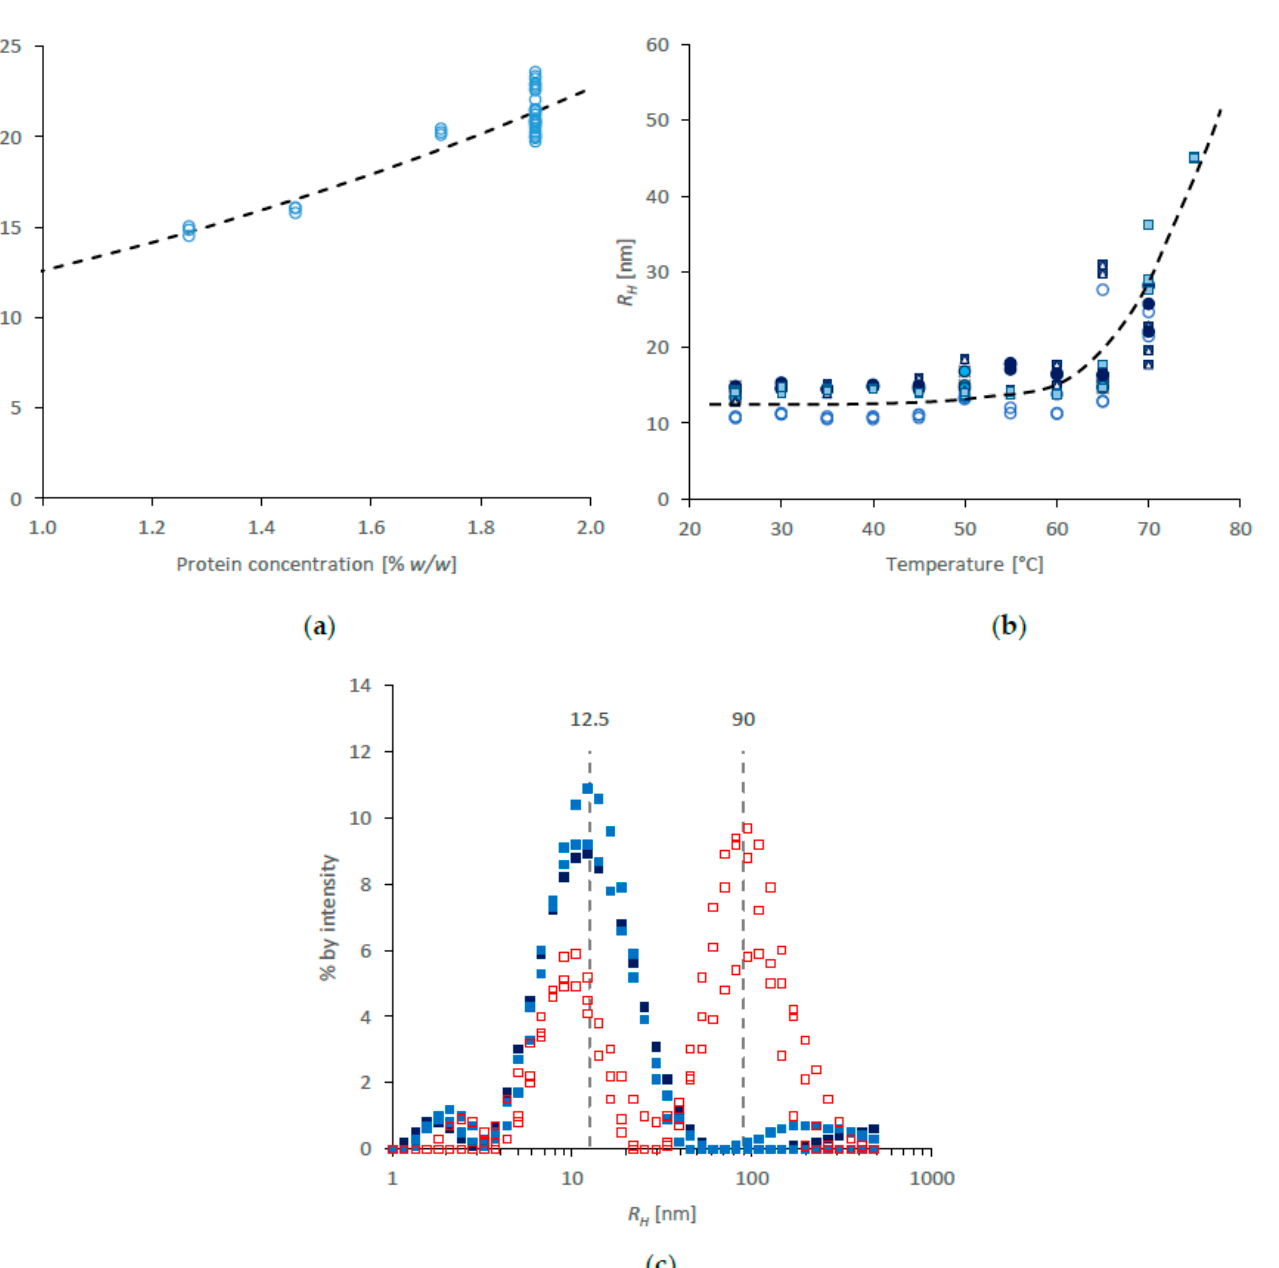
Figure 2 . DLS data for diluted NSF solutions ( a ) Effect of concentration on (apparent) hydrodynamic radius, ( b ) change in R H with temperature, different colours and shapes of symbols represent different specimens; ( c ) size distributions extracted from data at 25 °C (in blue) and 70 °C (in red). The dashed lines in ( a , b ) serve only as guides for the eye.